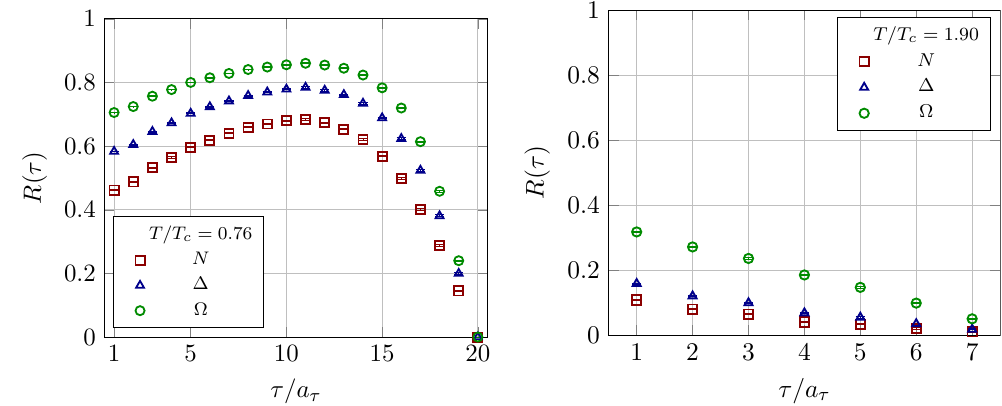
Figure 4 . Ratio R ( (cid:28) ) in the N , (cid:1) and (cid:10) channels, at T=T c = 0 : 76 (left) and 1.90 (right).